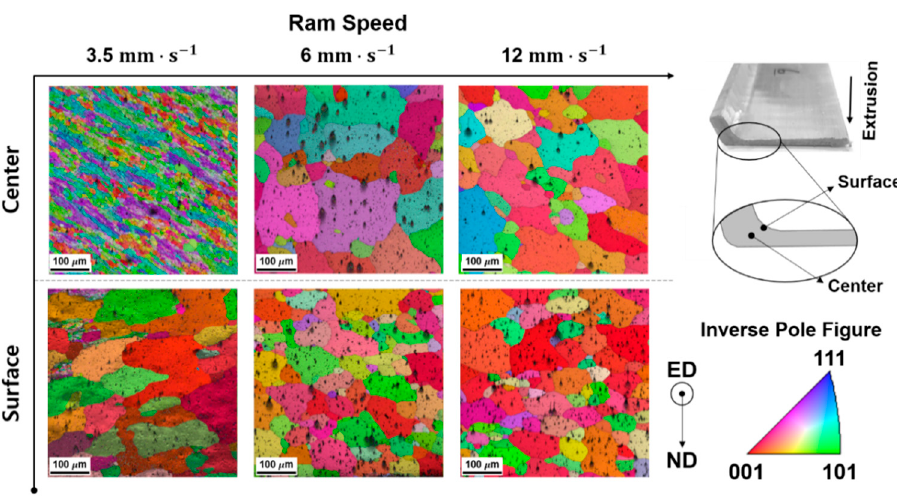
Figure 15. L-shaped samples extruded at various ram speeds. Figure 15. EBSD observations for the samples tested at various ram